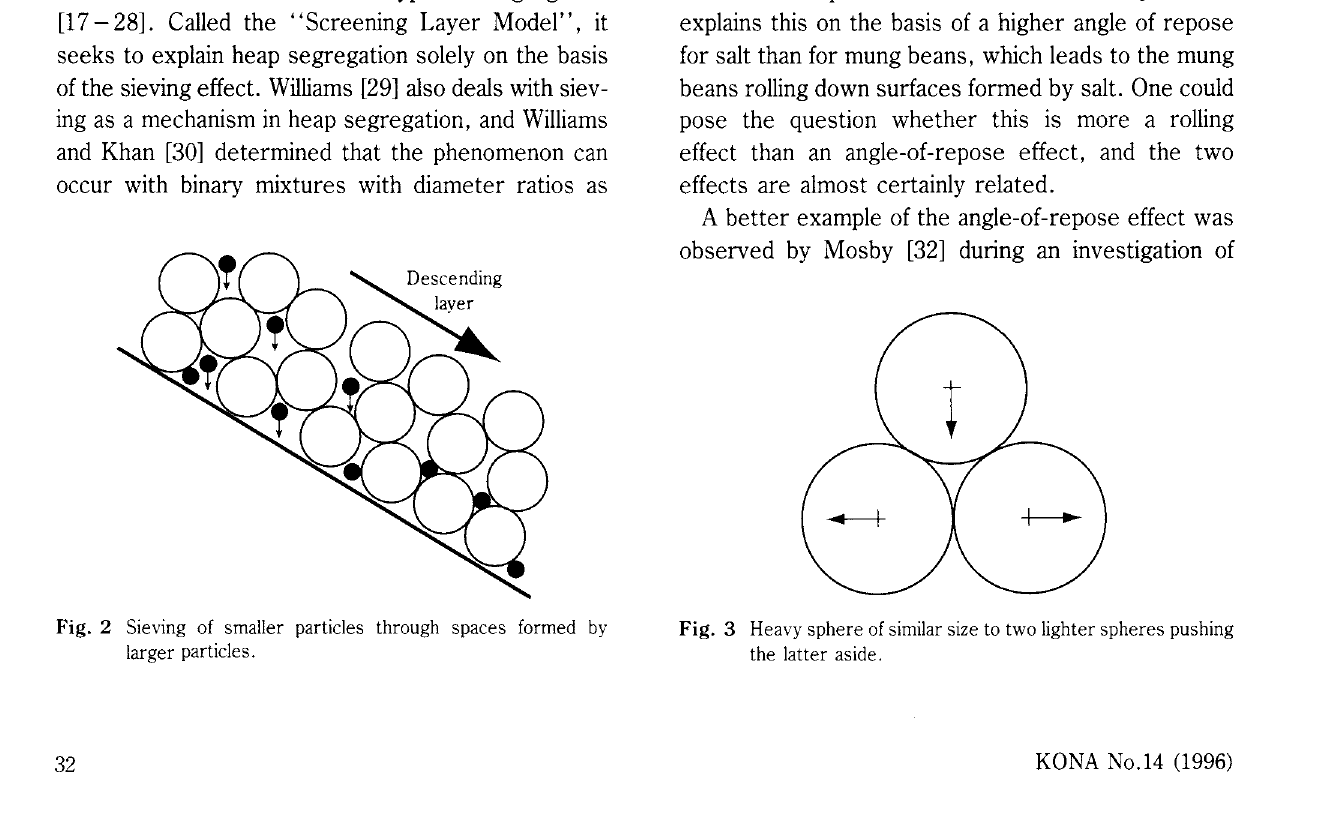
Fig. 2 Sieving of smaller particles through spaces formed by larger particles.